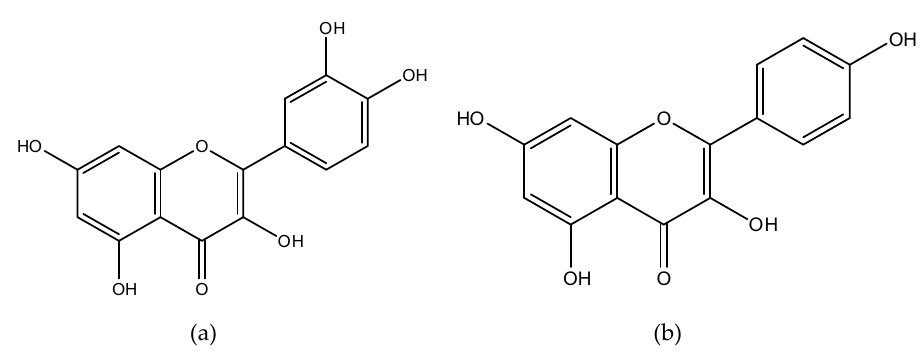
Figure 1: Structure of ( a ) quercetin and ( b )